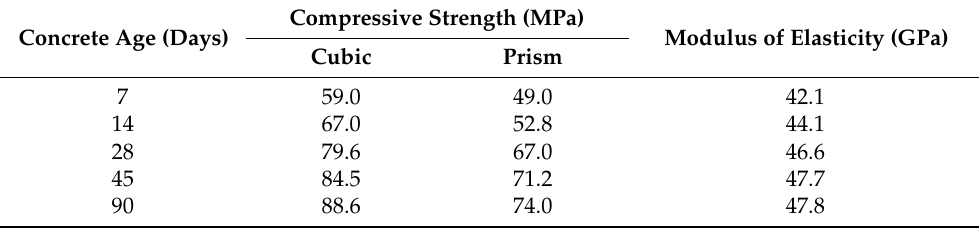
Table 1. Mechanical properties of concrete.